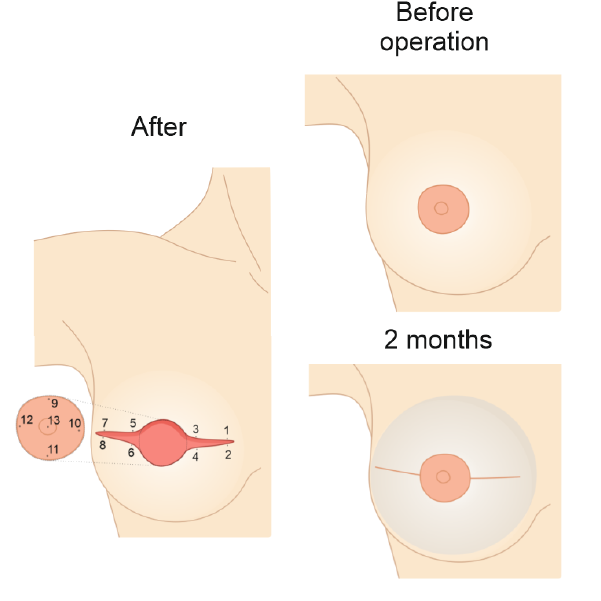
Figure 4. Graphical picture of the location of points for optical-spectral control of the area of skin incisions (before and after suturing the edges of the wound). Points 1–8 is a measurements points of border of breast wound, 9–12 is a measurements points of areola, point 13 corresponds to nipple.